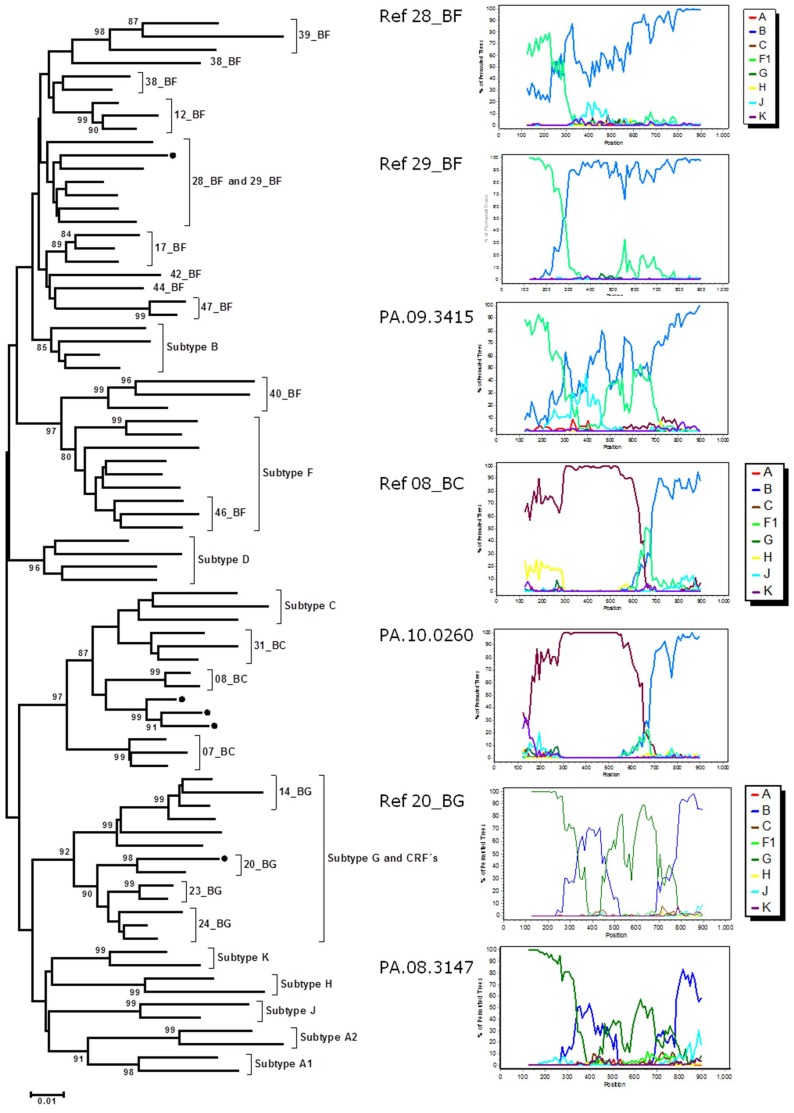
Phylogenetic Neighbor-Joining tree of HIV pol gene sequences from Panamanian HIV recombinant variants BF1, BC and BG clustered with circulating recombinant forms (CRF) references.Subtypes and CRF references are indicated at right of the brackets. Only bootstrap values of more than 80 are shown at the corresponding nodes. Panamanian isolates are shown with black circles. For clarity purposes, branches have been compressed by each subtype. Bootscanning plots of these recombinants are shown aside. Reference sequences used for bootscanning analyses shown by color (subtype B, blue; subtype F1, green; subtype C, purple; subtype G, dark-green and subtype A1, red).